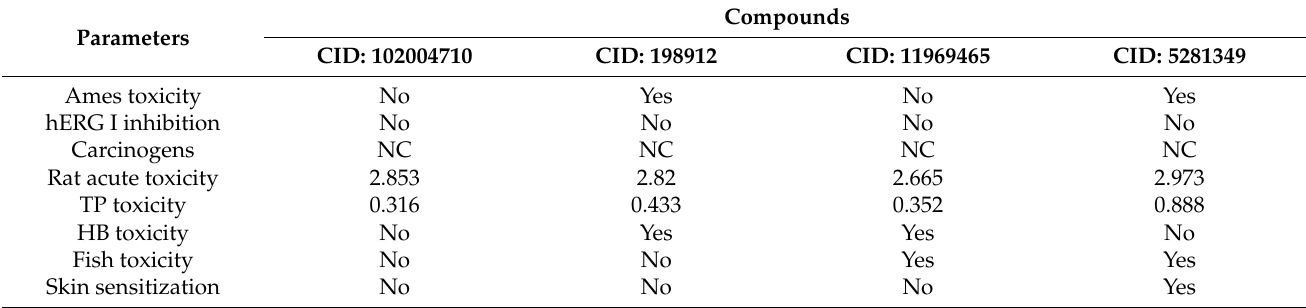
Table 3. Drug-induced AMES toxicity, hERG (I) inhibition, carcinogens, rat acute toxicity (LD50 in mol/kg), tetrahymena pyriformis (TP) toxicity, and skin sensitization activity of the four selected compounds. (NC indicates non-carcinogenic).